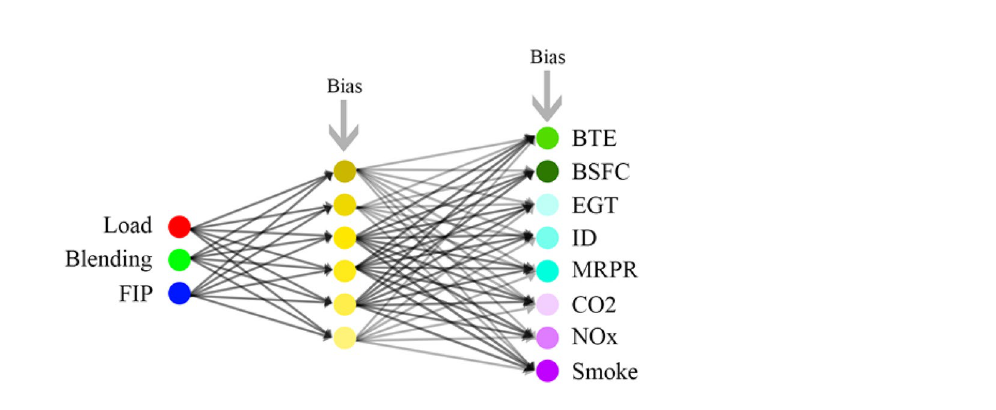
Figure 3. Schematic of